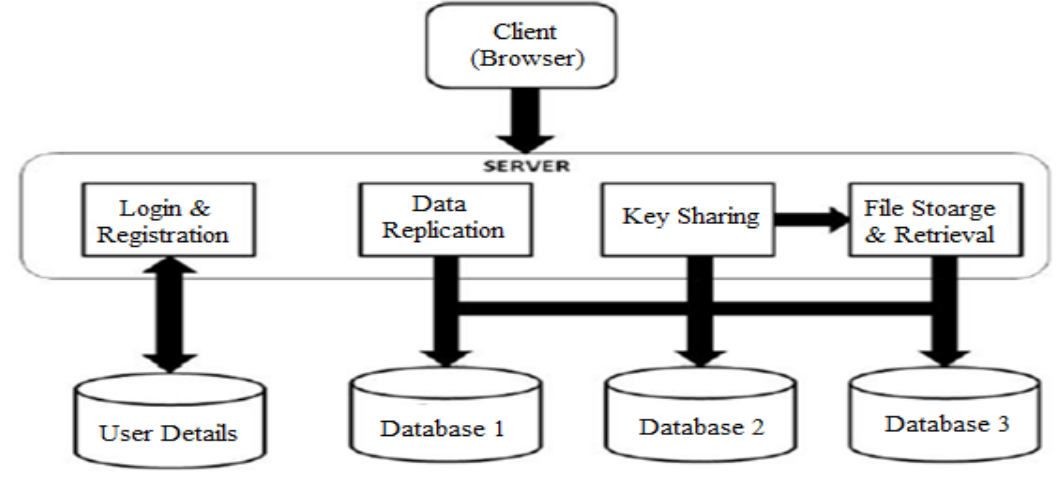
Figure 6 . Security Mechanism